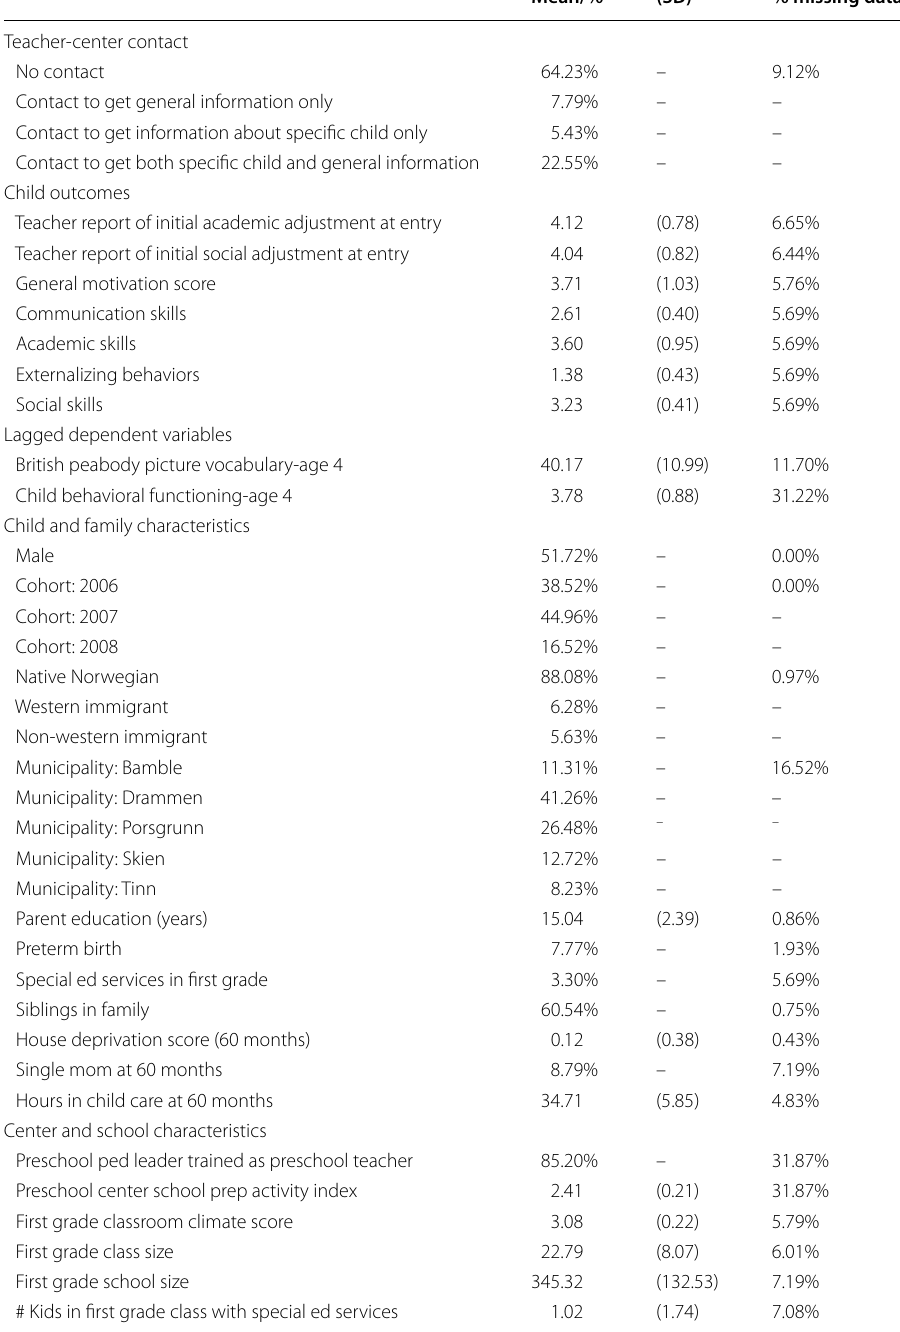
Table 1 Descriptive statistics for all variables included in